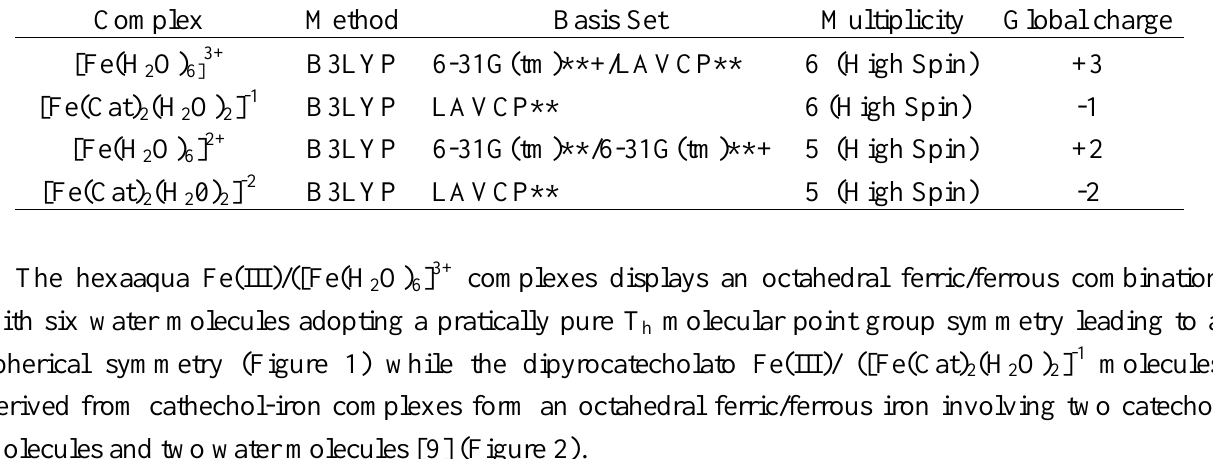
O) ] 3+ (T molecular point 2 6 h